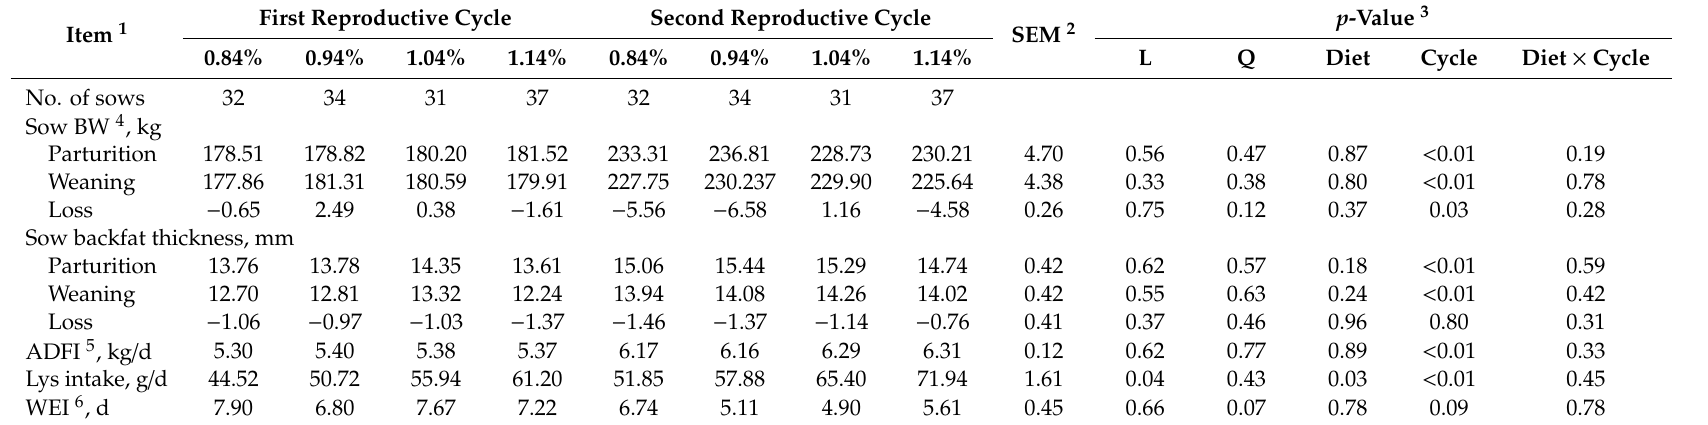
Table 2. E ff ects of di ff erent levels of lysine in lactation diets on sow